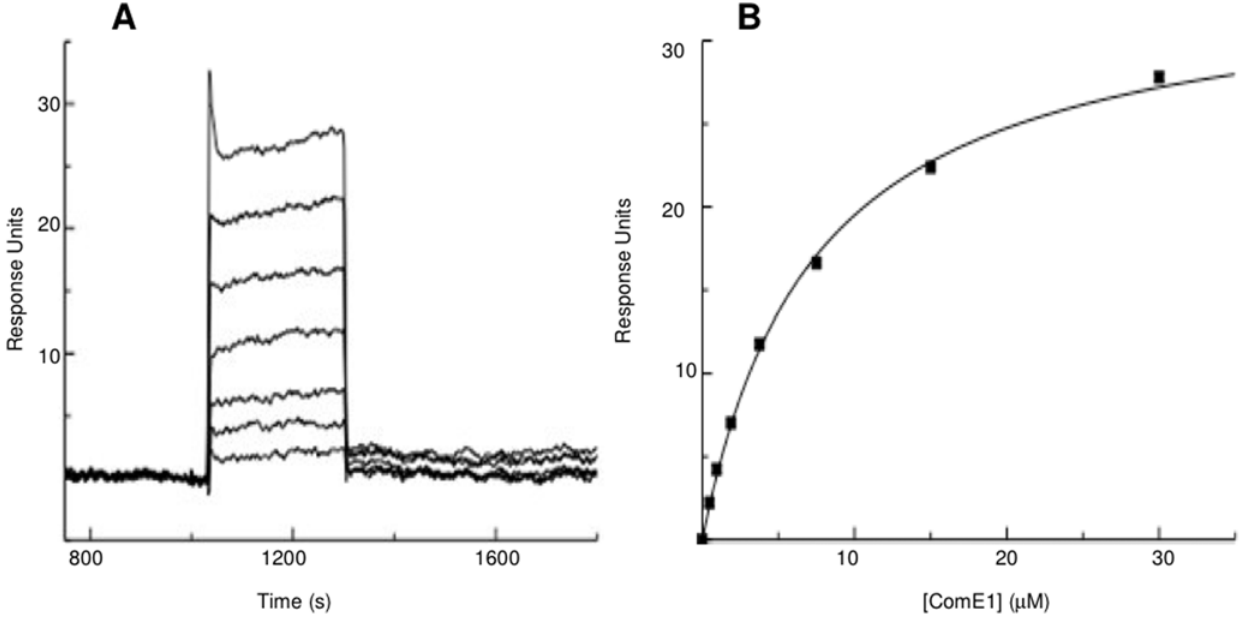
Figure 4. SPR analysis of binding of ComE1 from P.multocida to pUC19 DNA. [A] – pUC19 was immobilised on a SA sensor chip and increasing concentrations of ComE1 (1.1 m M, 2.2 m M, 4.4 m M, 8.5 m M, 17 m M, and 34 m M) were injected at a flow rate of 10 m l min 2 1 and the binding response recorded as response units (RU). Data are representative of three separate experiments. [B] – The equilibrium response for binding to Fn at each concentration of ComE1. Data are representative of three separate